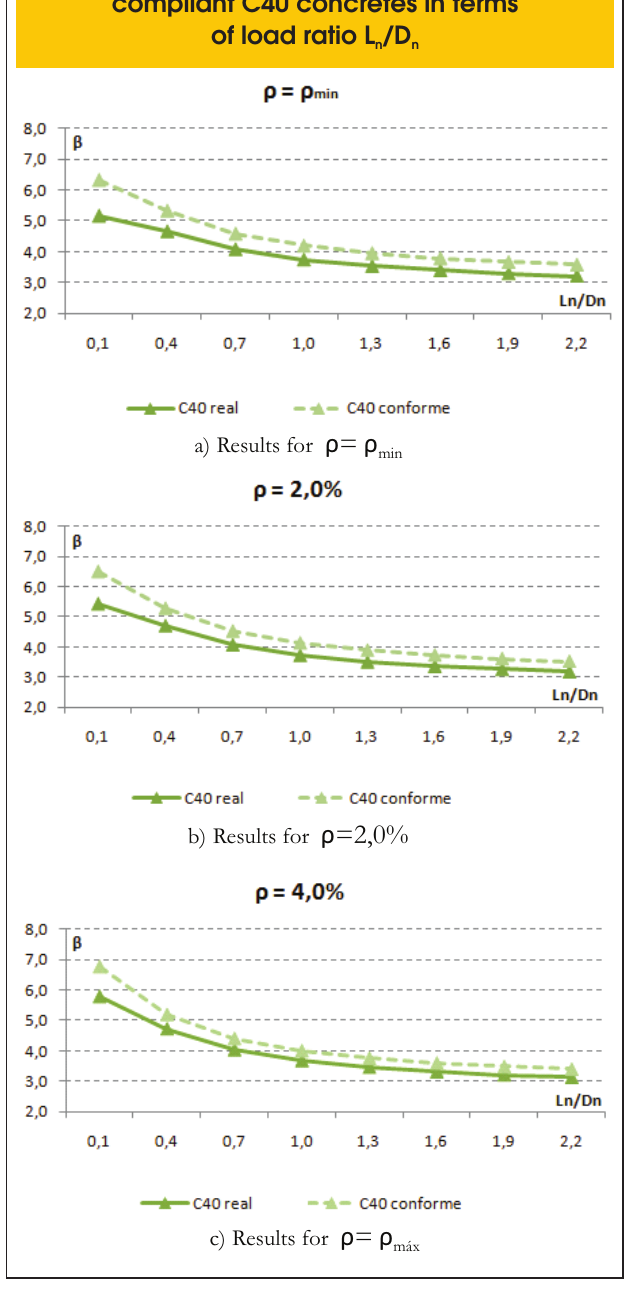
Figure 7 – Reliability index results for real and compliant C40 concretes in terms